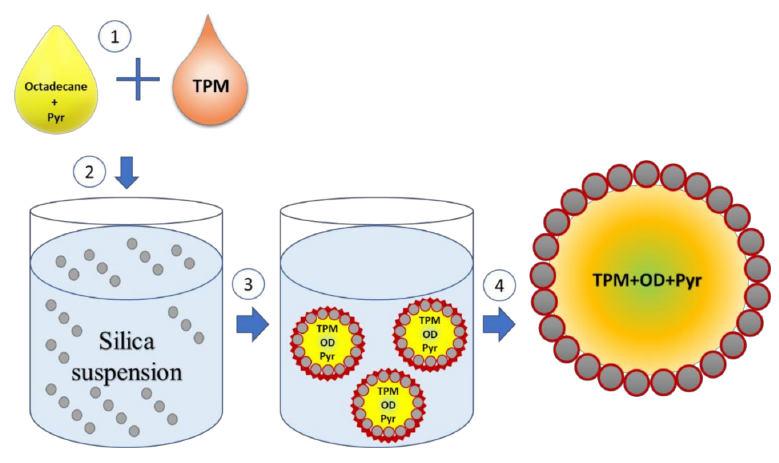
Figure 1. Illustration of the procedure of submicrocapsules